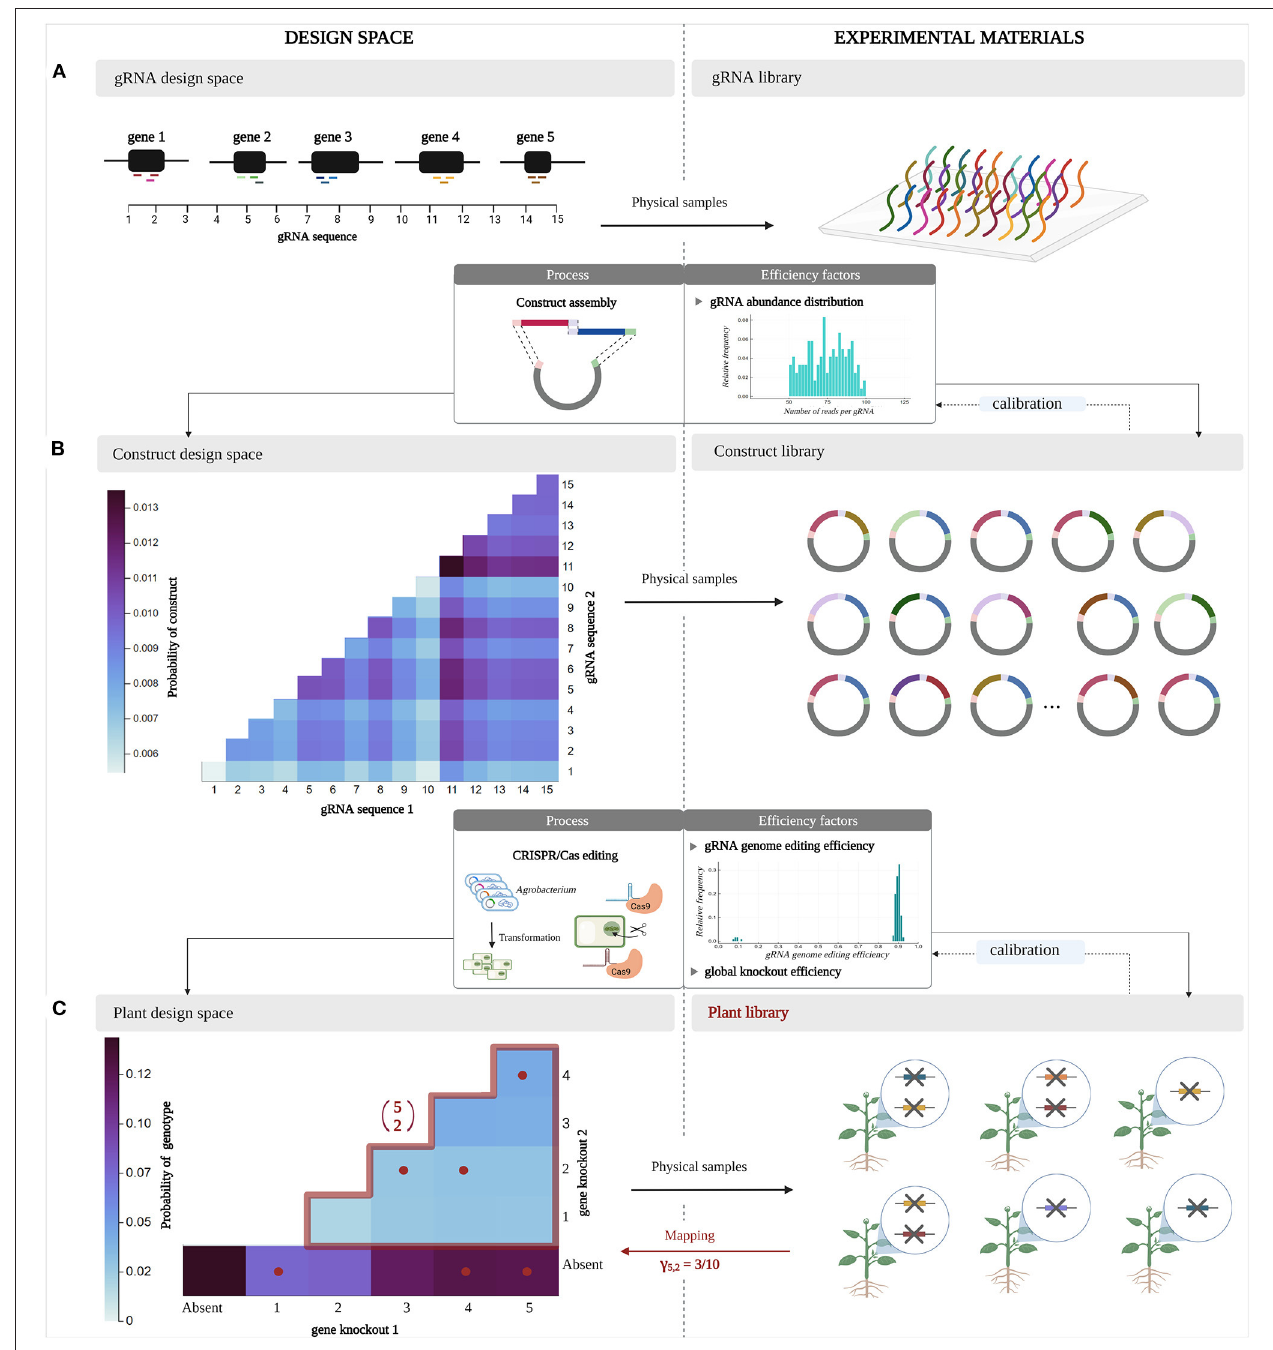
FIGURE 2 | Design space representation and parallel experimental materials at different stages in a multiplex CRISPR/Cas experiment. A design space at a certain point in the experiment is considered as a virtual space encompassing all possible designs, whereas a library represents a collection of physical samples from the design space. These material experimental units are obtained by random sampling of the design space according to a sampling distribution, which describes the probability of sampling each design and is determined by inefficiencies at different stages of the multiplex CRISPR/Cas protocol. (A) Here, an experiment targeting pairwise combinations of five target genes is considered. Three gRNAs are designed per gene. (B) In the construct library, two gRNAs are included per gRNA/Cas construct. (C) The resulting plant library contains up to two gene knockouts per plant.